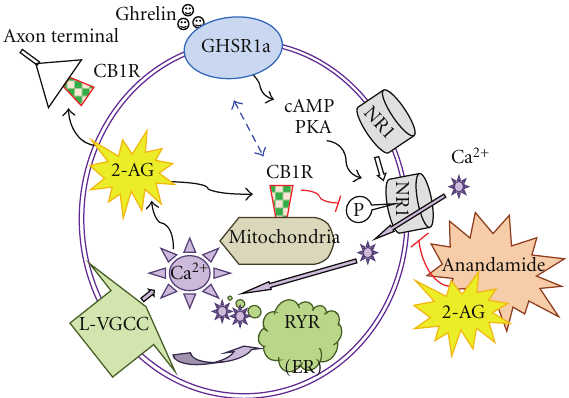
Figure 5: Endocannabinoids negatively regulate ghrelin-induced enhancement of synaptic receptor functions by inhibiting the phos- phorylation of NR1. CB1R (type 1 cannabinoid receptor), GHSR1a (type 1a ghrelin receptor, aka growth hormone secretagogue receptor), PKA (protein kinase A), RYR (ryanodine receptor), ER (endoplasmic reticulum), L-VGCC (L-type voltage-gated calcium channel), 2-AG (2-arachidonoyl